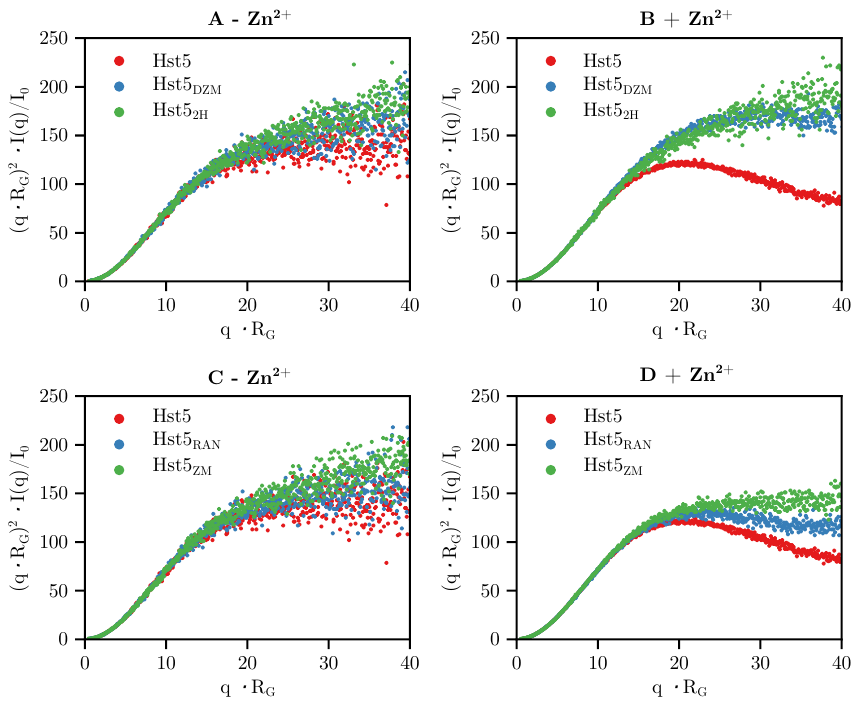
Figure 5. Kratky plots visualising the difference in shape between Hst5 in the absence and presence of Zn 2+ . ( A , B ) shows Hst5, Hst5 DZM , and Hst5 2H in the absence and presence of Zn 2+ , respectively. ( C , D ) shows Hst5, Hst5 RAN , and Hst5 ZM in the absence and presence of Zn 2+ ,